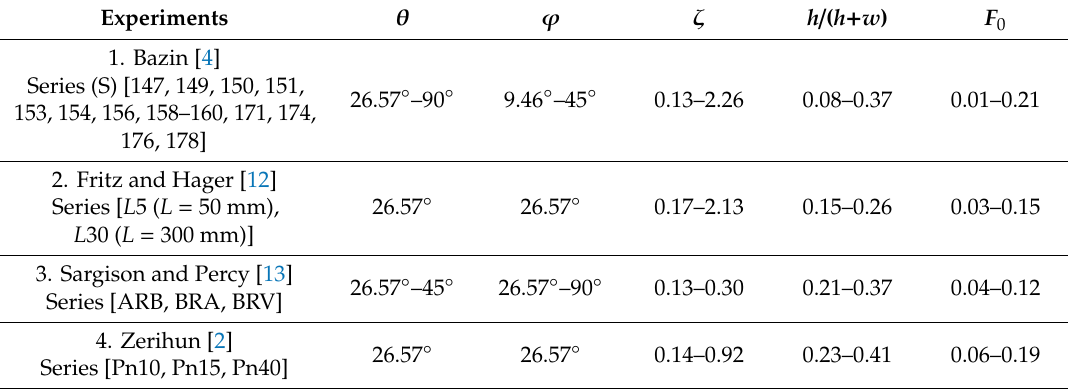
Table 1. Summary of scope of experimental